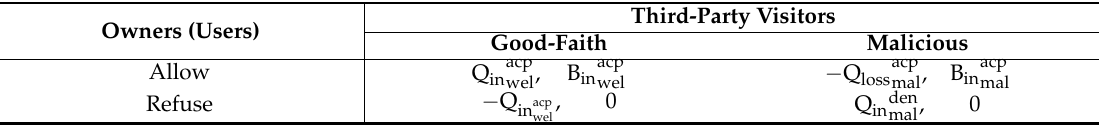
Table 1. Analyzing the reward matrix in the traditional privacy protection